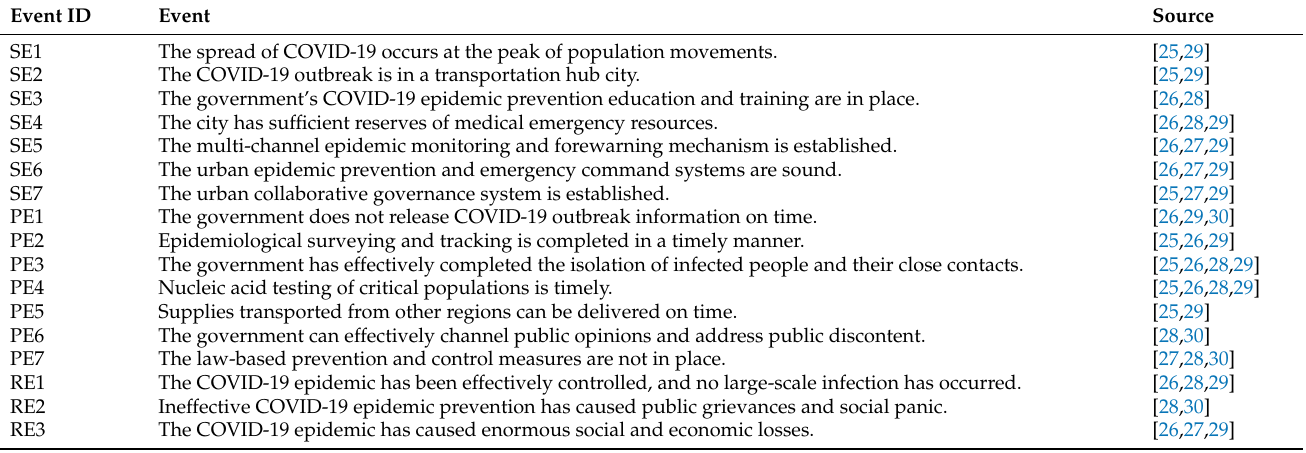
Table 4. Critical events of COVID-19 prevention and control for the CIA-ISM